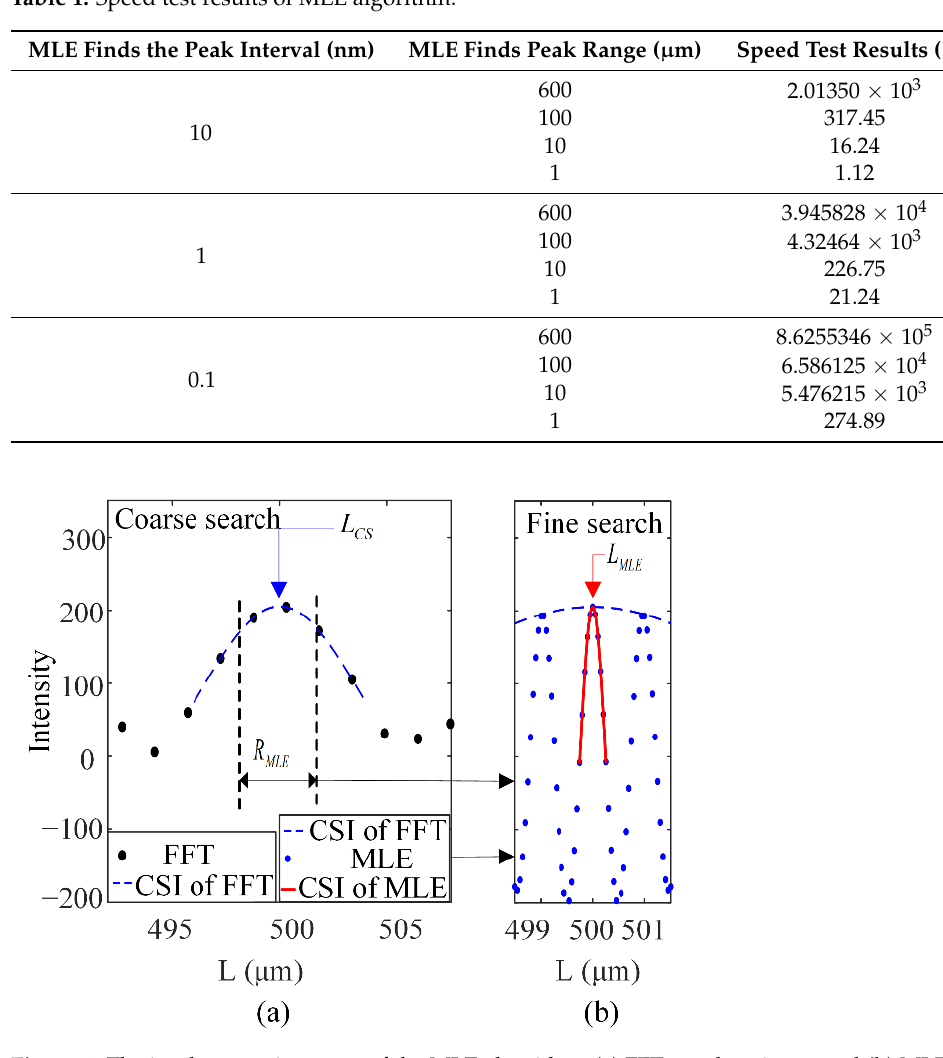
Table 1. Speed test results of MLE algorithm.